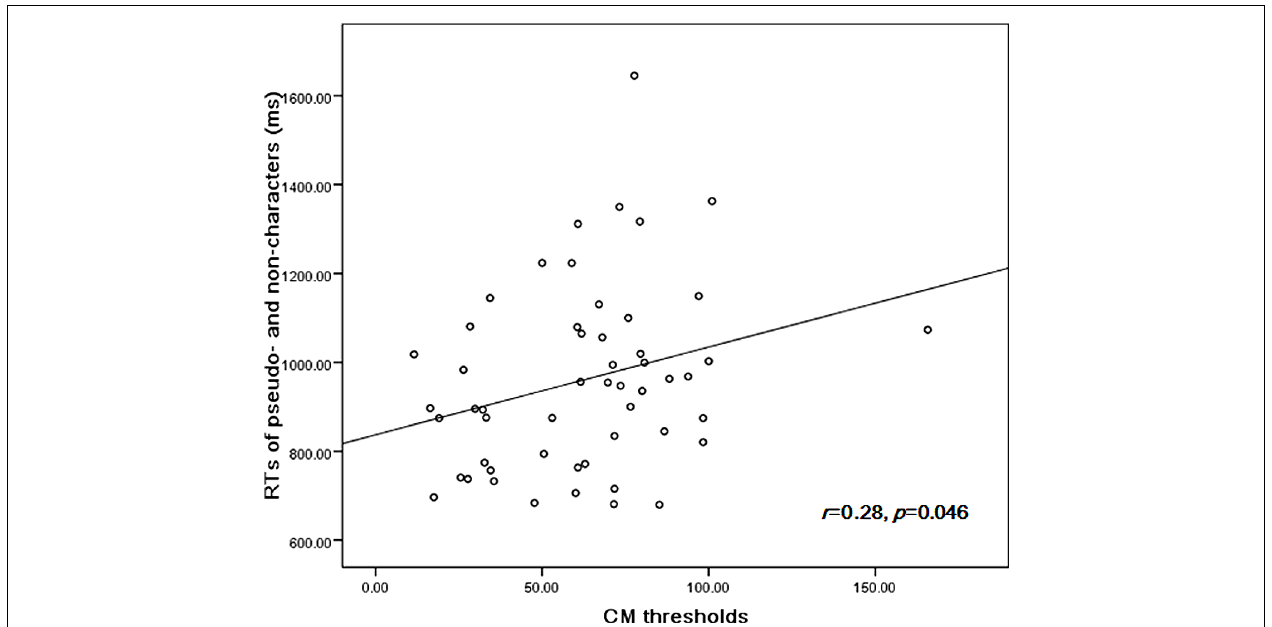
FIGURE 2 |The correlation between CM thresholds and average RTs of pseudo-characters and non-characters.